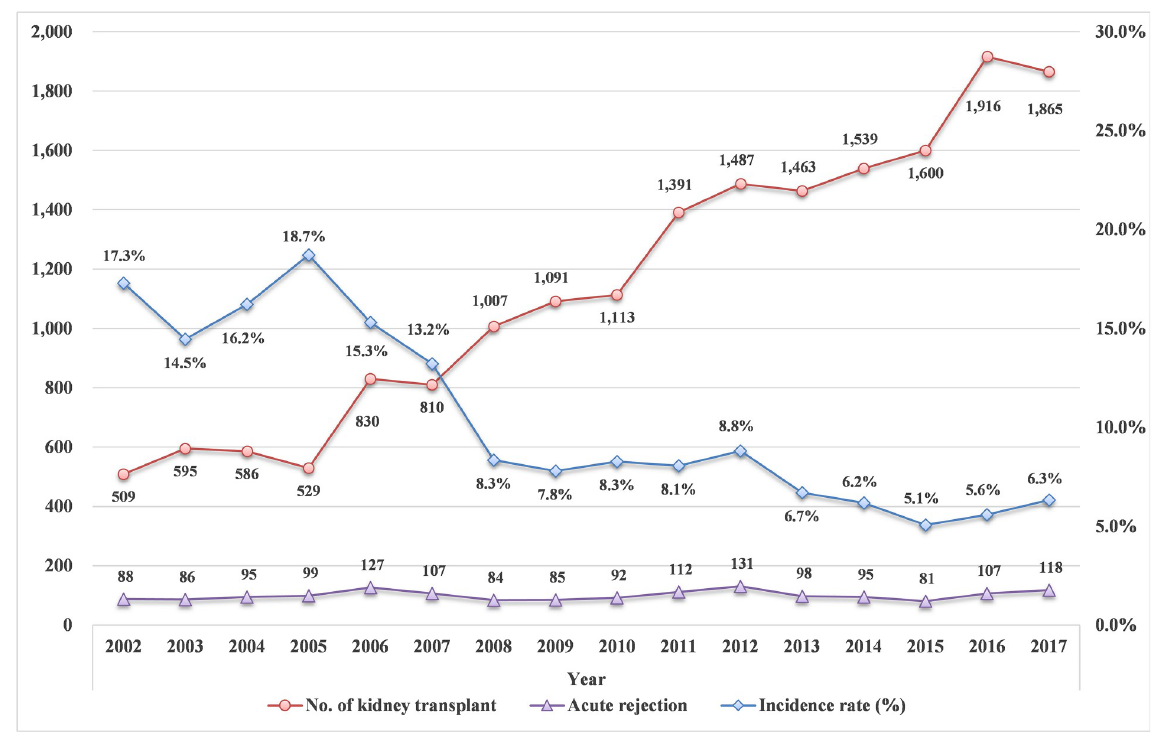
Fig 1. The incidence of acute rejection during hospital stay for kidney transplant by year. The incidence rate of acute rejection shows a tendency of steady decrease over 16